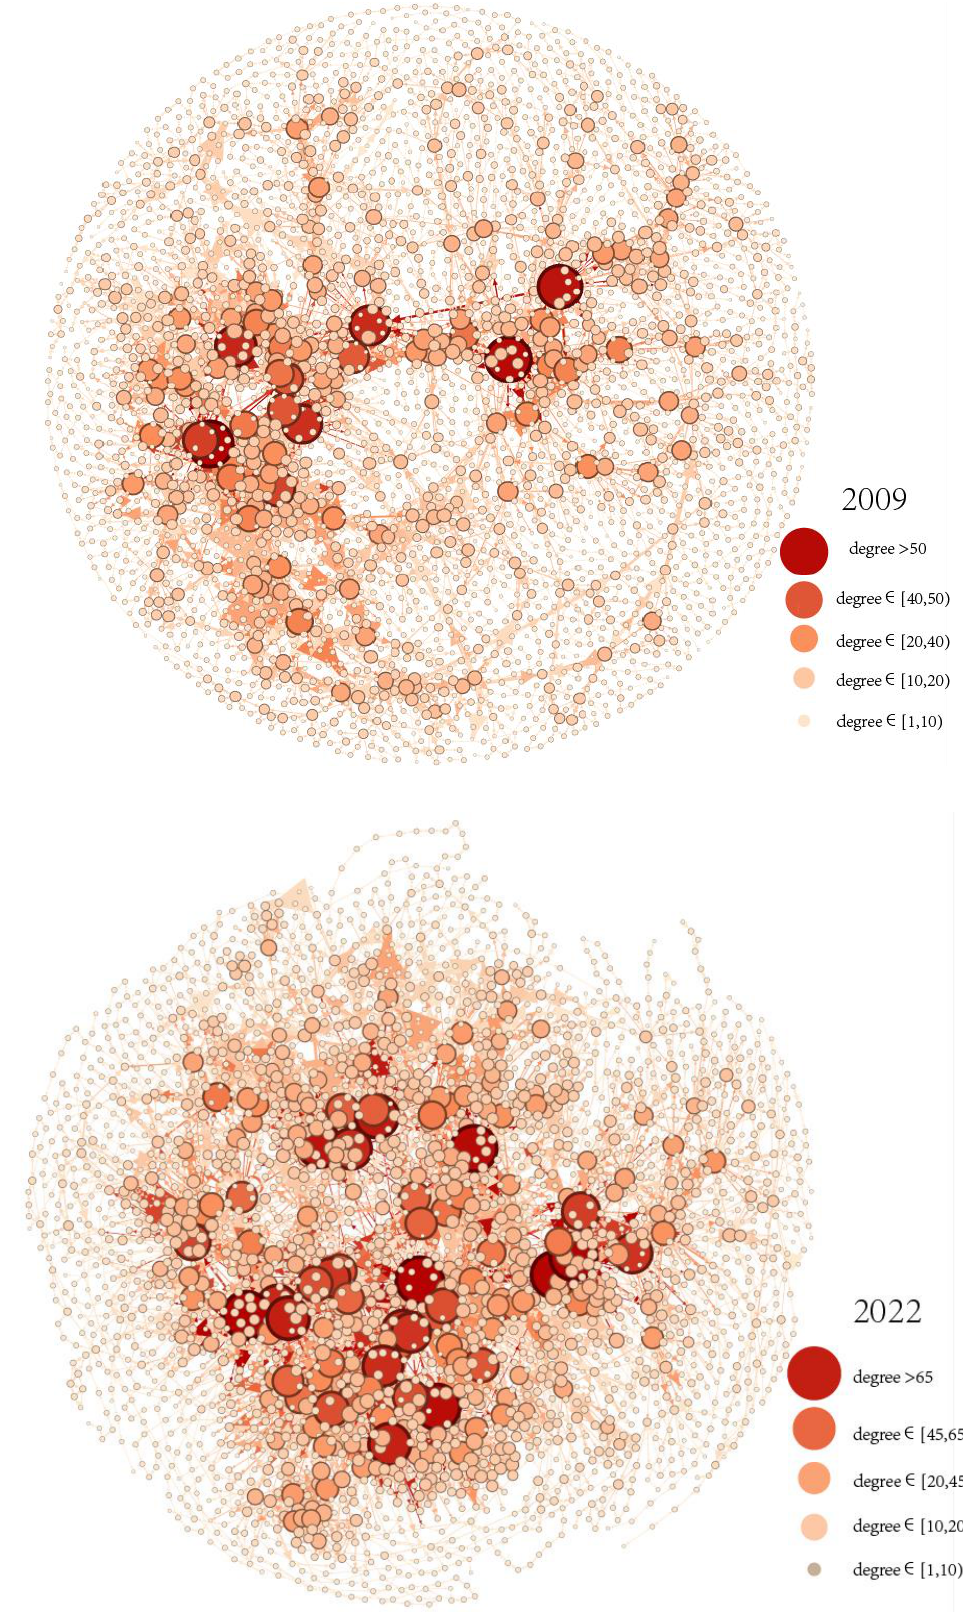
Figure 1. Railway station network layout in 2009 and 2022.